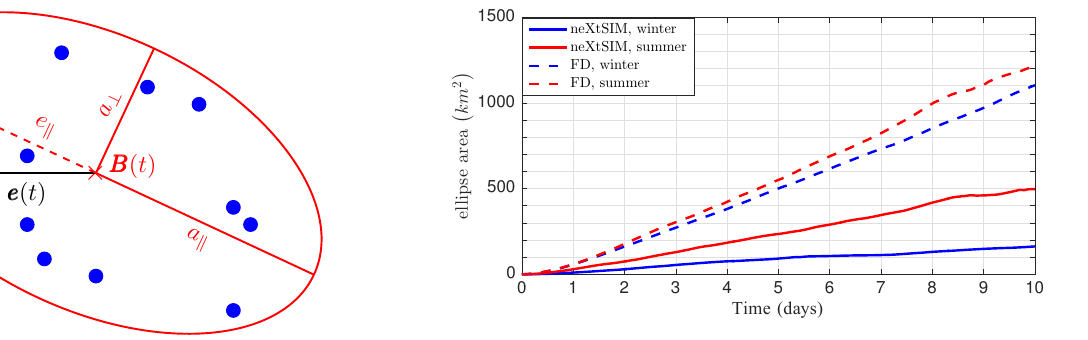
Figure 17. Time evolution of the averaged ellipse areas for neXtSIM (solid lines) and FD (dashed lines) in winter (blue) and in summer (red).